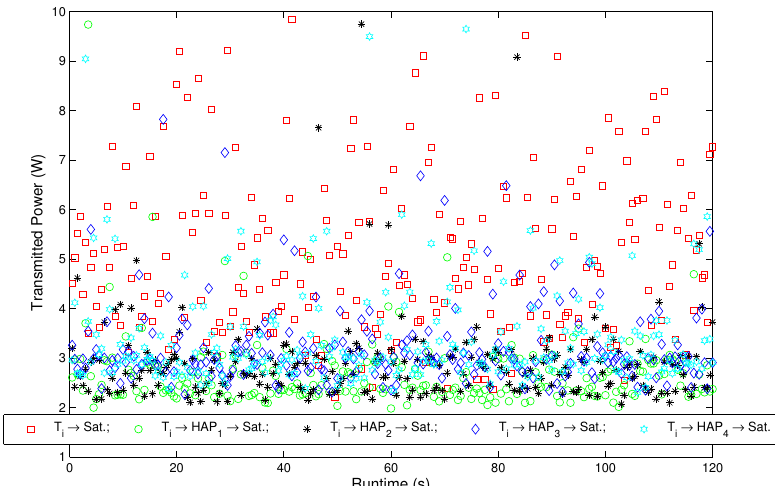
Figure 2. Transmitted power calculated by the direct and relay links versus runtime, before applying the energy-efficient path